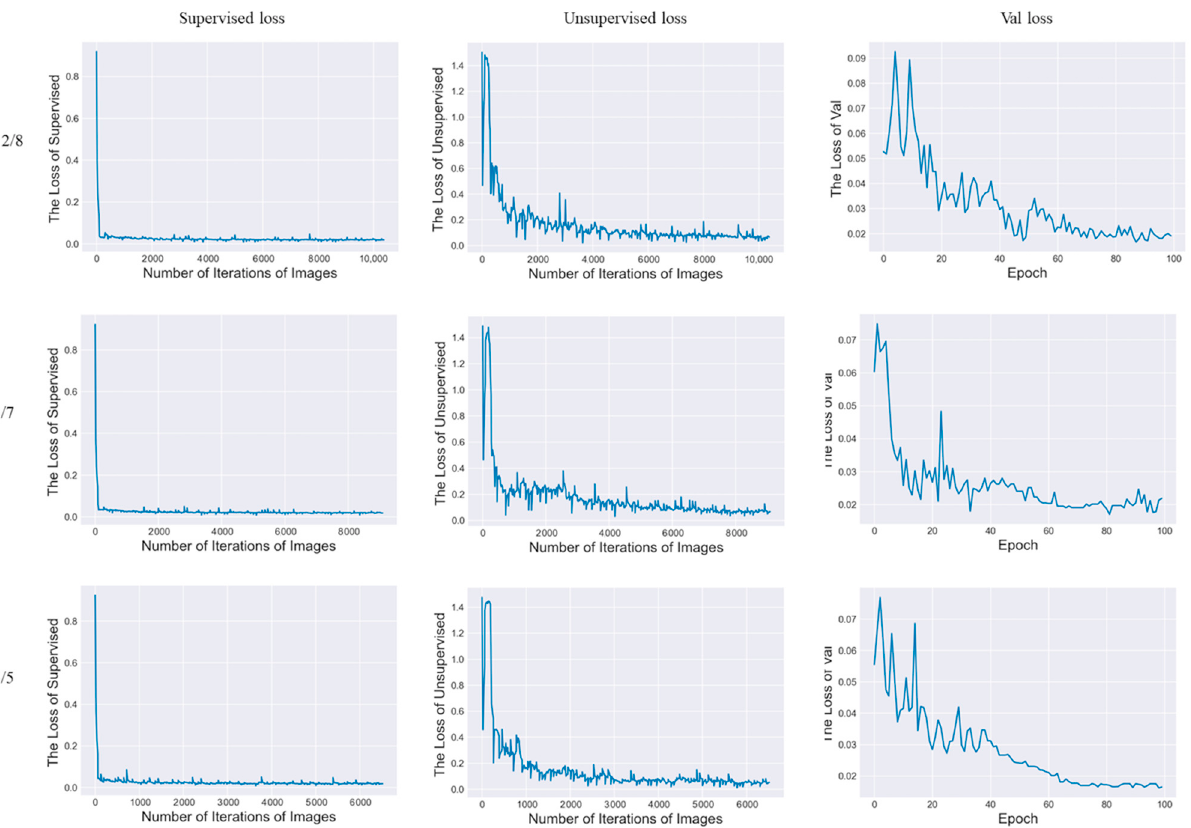
Figure 14. Loss curve for supervise training loss, unsupervised training loss and validation loss on the Corsican dataset. Table 5. Parameters of each